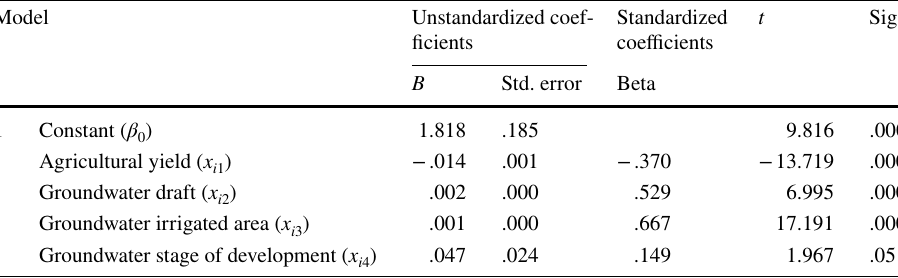
a. Dependent variable: groundwater level ( y